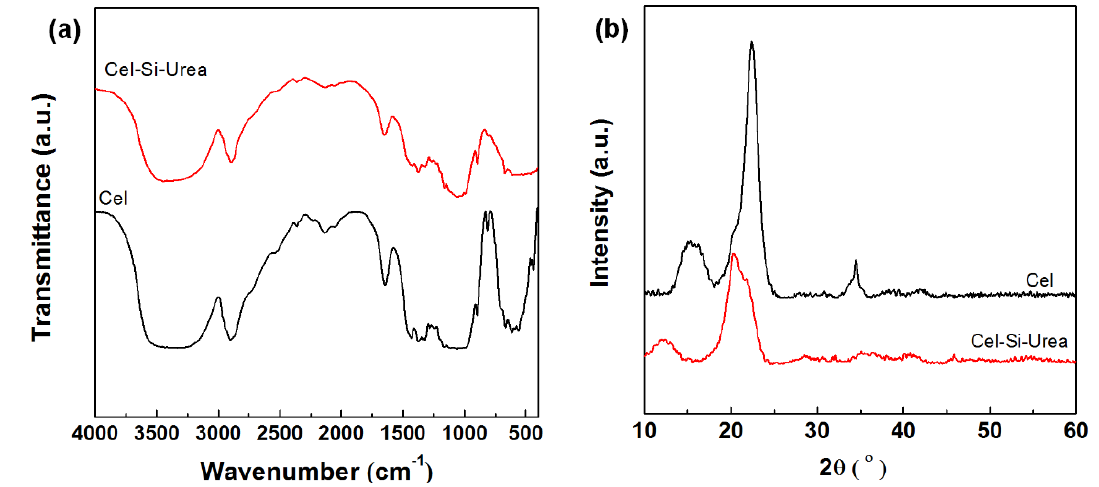
Figure 2. FT – IR spectra ( a ) and XRD patterns ( b ) of the pristine cellulose (Cel) and the urea-terminated silane-modified cellulose (Cel-Si-Urea).